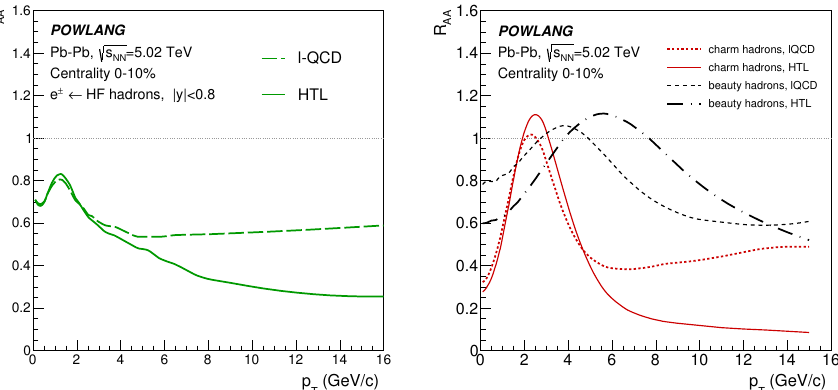
Figure 15 . The nuclear modi(cid:12)cation factor of electrons from semi-leptonic decays of heavy-(cid:13)avour p hadrons in central Pb-Pb collisions at s NN =5 : 02 TeV. POWLANG results with HTL and l-QCD transport coe(cid:14)cients are compared. In the right panel we display the corresponding results for the R AA of the parent charm and beauty